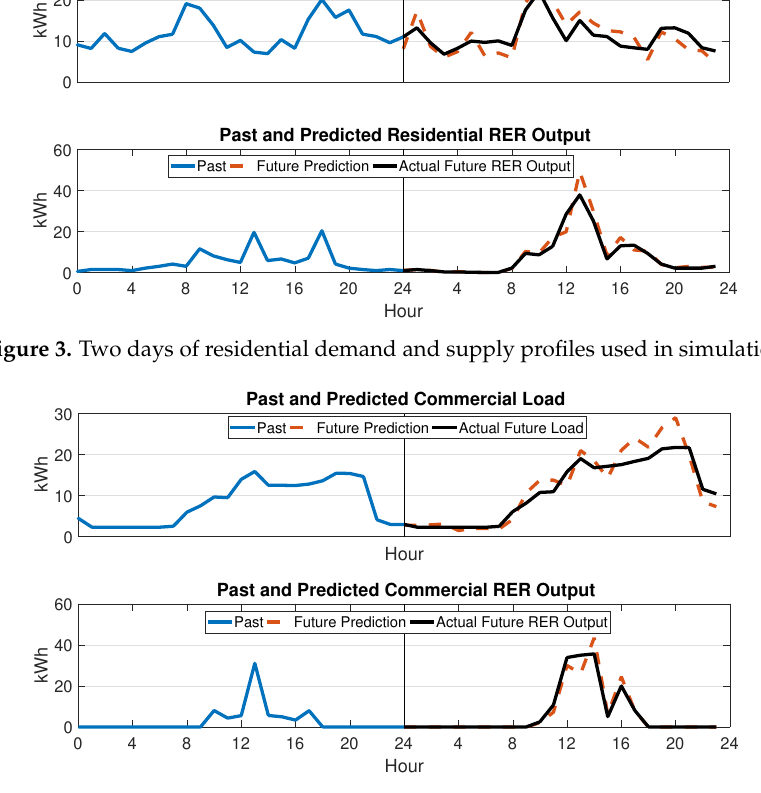
Figure 4. Two days of commercial demand and supply profiles used in